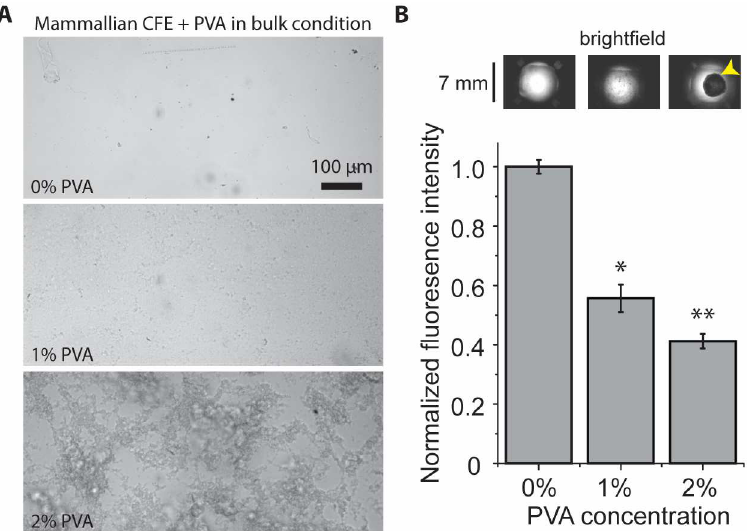
Fig 4. PVA surfactant caused the formation of aggregate and reduced CFE activity. (A) Brightfield images of mammalian CFE at 0, 1, or 2% of PVA surfactant. (B) eGFP expressionin HeLa CFE as a function of PVA concentration measuredin microwellplates (n = 3, ± S.E.), unpairedt test comparingwith 0%; * : p < 0.01; ** : p < 0.001. Brightfield images of microwell correspondingto the different PVA concentration are shown on top. Yellow arrowhead points to the large aggregate in the